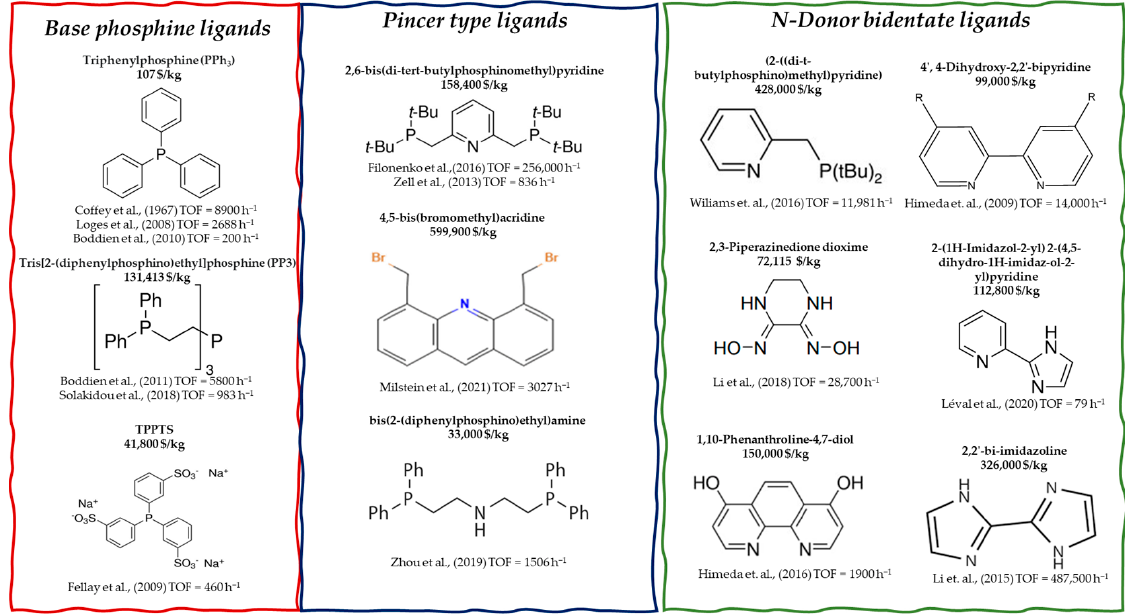
Figure 11. Chemical structure of selected ligands used in cost analysis, from various catalytic systems.